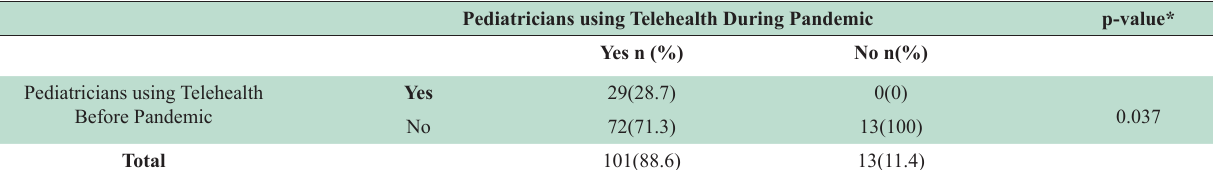
Table-I: Pediatricians using Telehealth Before and During pandemic (n=114).